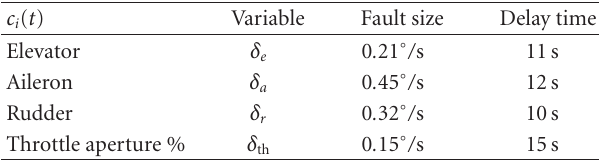
Table 5: NLGA FDI technique: minimal ramp faults with ν =